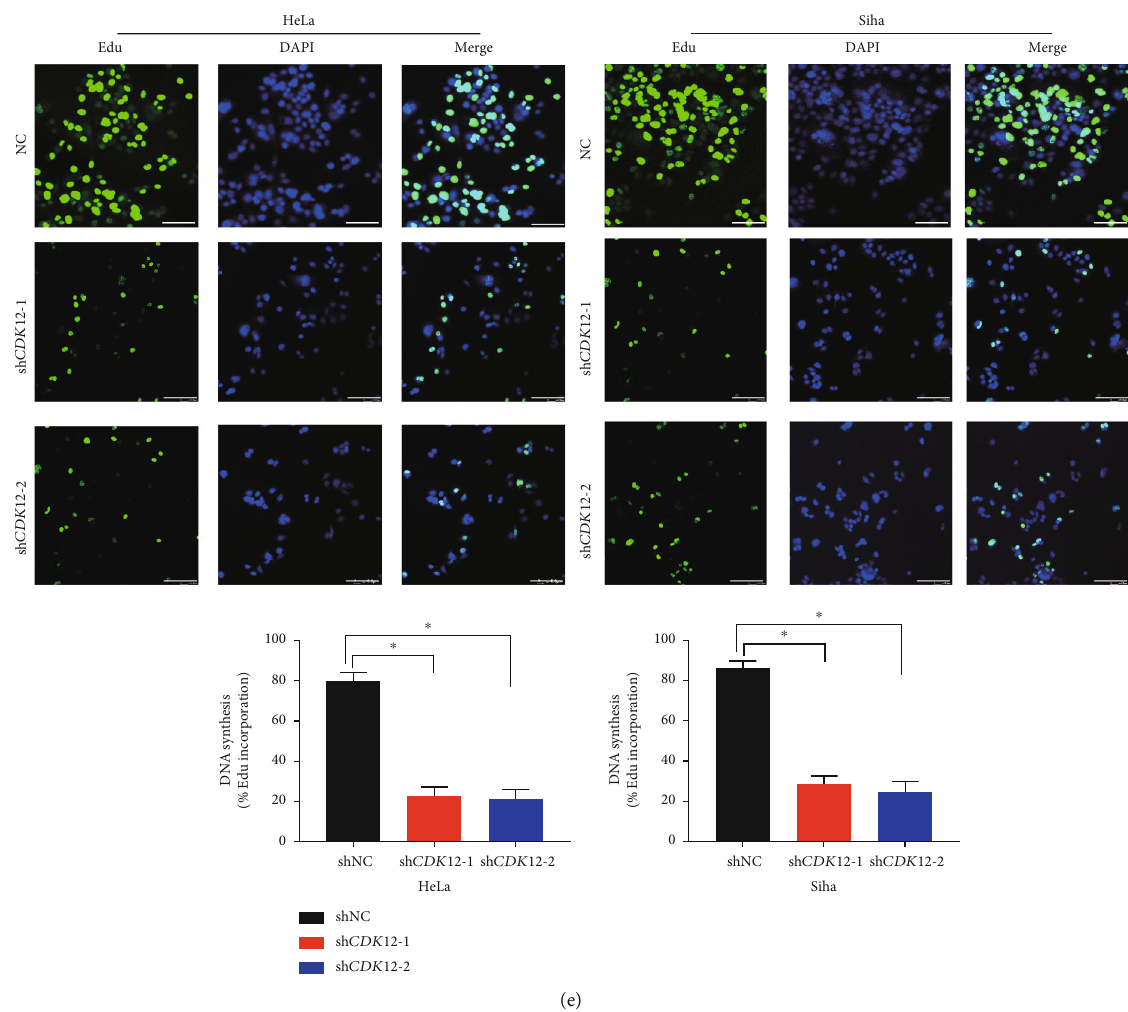
Figure 2: Cyclin-dependent kinase 12 ( CDK12 ) promotes cervical cancer cell proliferation in vitro . (a) The cell growth of HeLa and Siha cells in three groups (shNC, sh CDK12 -1, sh CDK12 -2) were analyzed with CCK-8 assay. (b) The cell growth of HeLa and Siha cells in the two groups (lentivector and lenti- CDK12 ) were analyzed with CCK-8 assay. The results are shown as the means ± standarddeviation of the OD450 value. (c) The colony formation assay and quanti fi cation of HeLa and Siha cells in three groups (shNC, sh CDK12 -1, sh CDK12 -2) were shown. (d) The colony formation assay and quanti fi cation of HeLa and Siha cells in two groups (lentivector and lenti- CDK12 ) were analyzed. (e) EdU staining assay analysis. Representative EdU staining and quanti fi cation ratio of proliferation cells. Error bars represent mean ± standard error of the mean. Scar bar: 50 μ m. Two-tailed t -test, ∗ P < 0 : 05